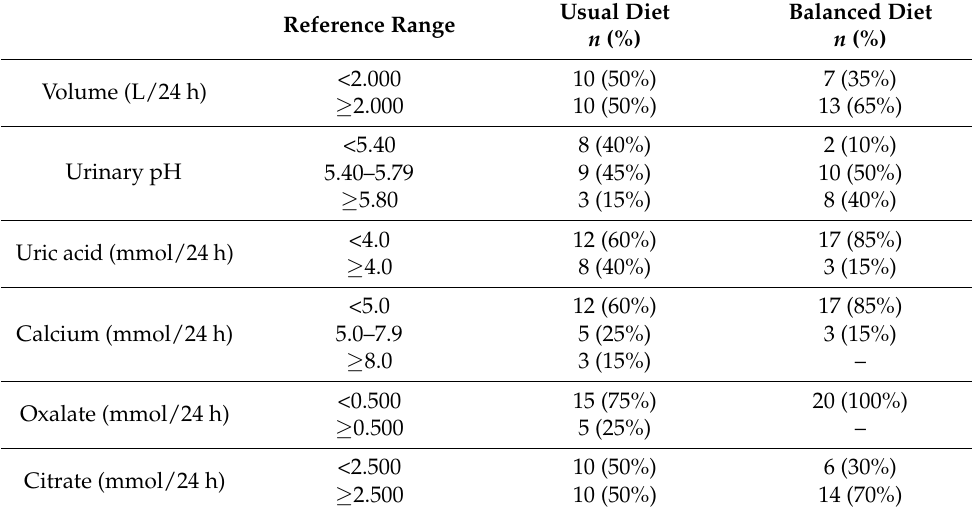
Table 3. Urinary abnormalities under the usual diet and balanced mixed diet.